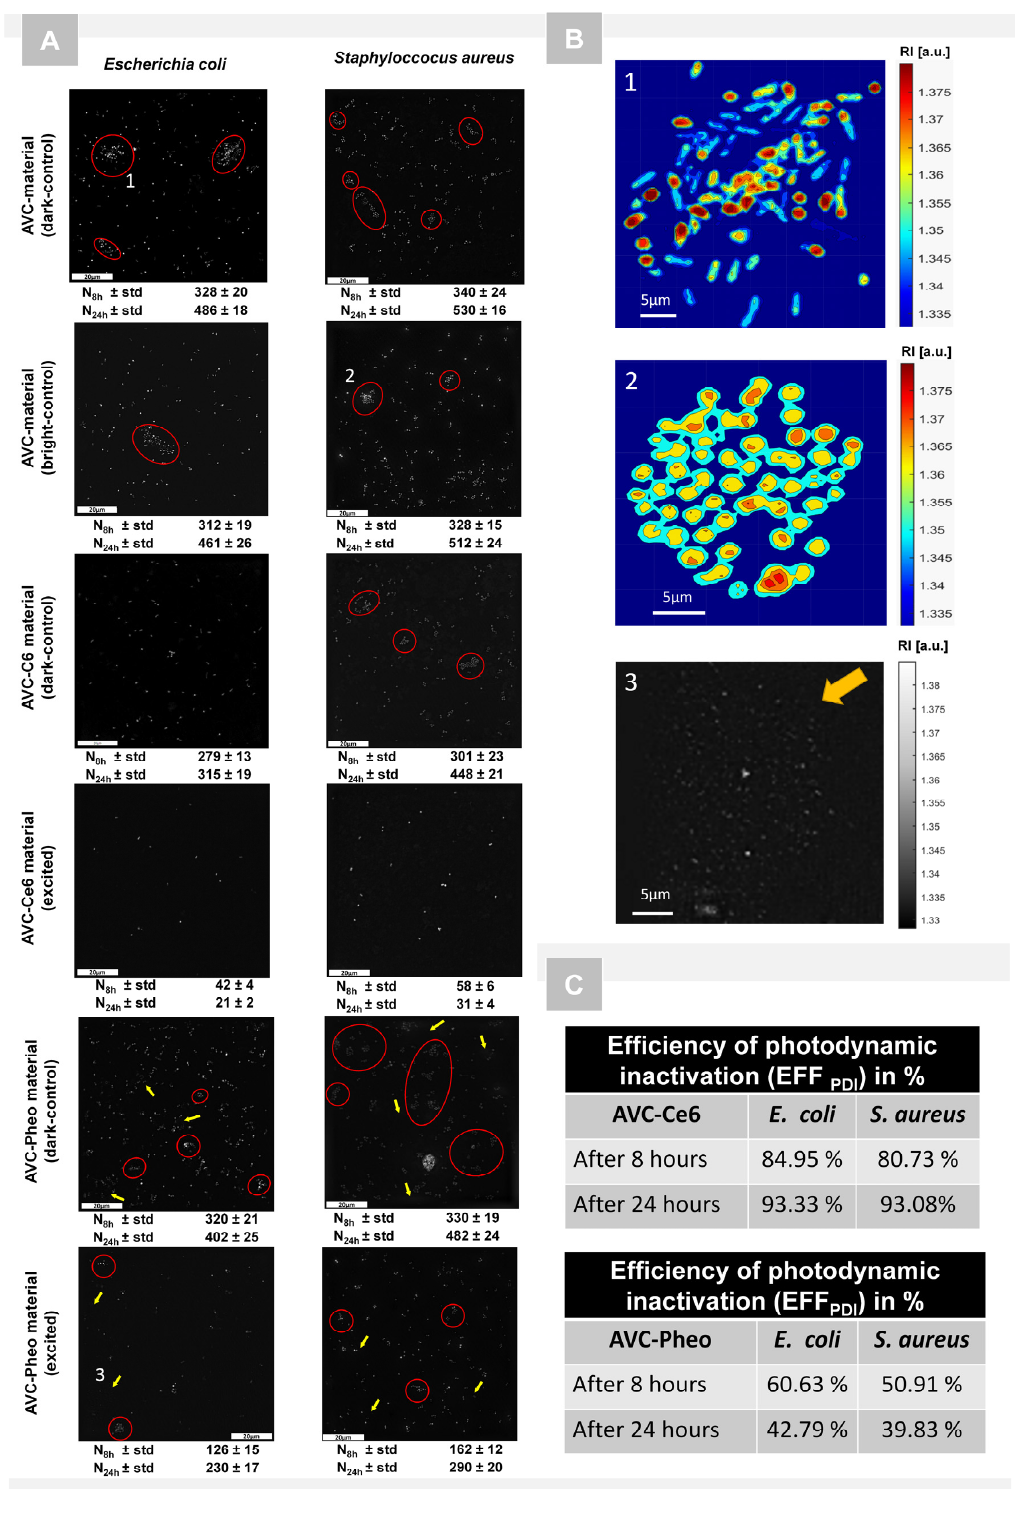
Figure 5. ( A ) Representative 2D-RI maps of E. coli and S. aureus cells grown on the surface of three kinds of AVC materials (24 h after photodynamic treatment) mean values of the cells’ number (N 8h , N 24h ) and its standard deviation 8 and 24 h after photoexcitation. (Red ellipses indicate the bacterial cells clusters characteristic for biofilm formation; yellow arrows indicate the photosensitizer’s aggregates in the material). ( B ) The exemplary enlarged 2D-RI maps of characteristic structures (cells clusters—( 1 , 2 ); aggregates—( 3 )) indicated on ( A ). ( C ) The efficiency of the photodynamic inactivation EFF PDI (detailed description in Section